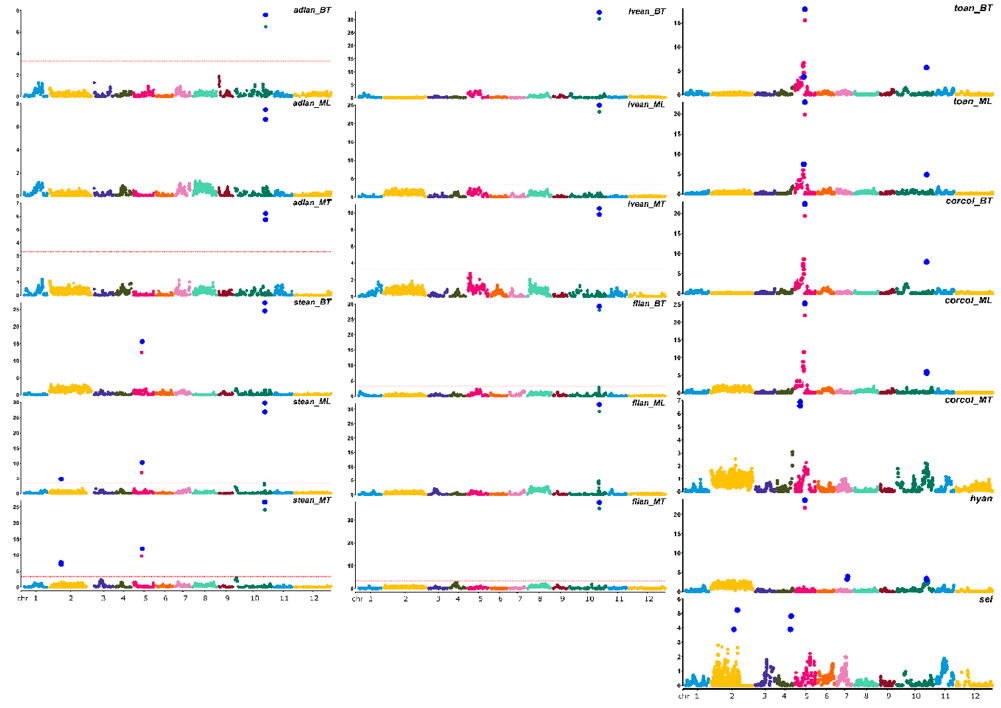
Figure 3. QTLs identified for the traits in study. Blue dots represent markers within the confidence interval of the QTL (LODmax − 1 interval), with LOD values plotted against genome locations. Red lines in the Manhattan plots indicate LOD significance threshold.